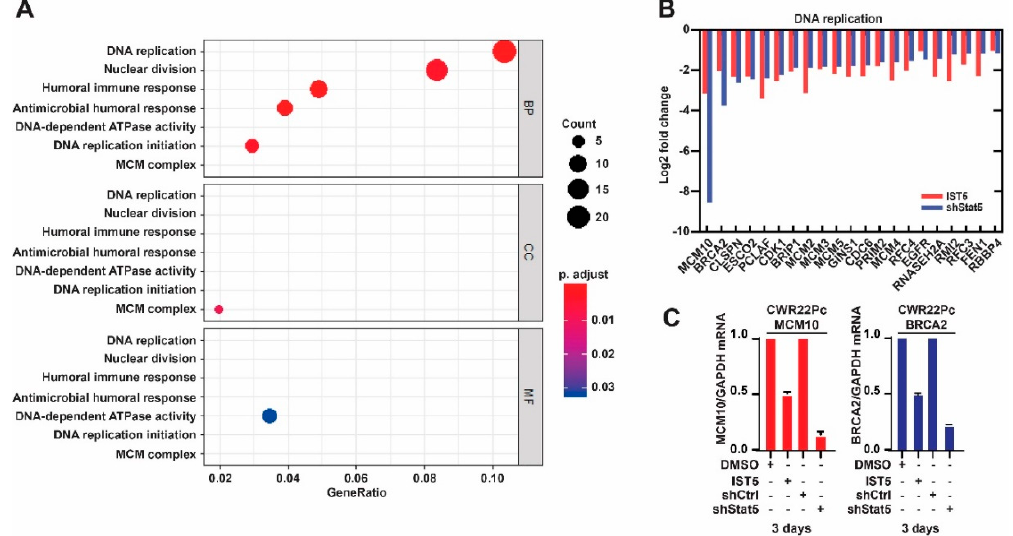
Figure 3. Pathway enrichment analysis of genes regulated similarly by IST vs. genetic knockdown of Stat5 in prostate cancer cells. ( A ), a dot plot of functionally enriched pathways in the genes regulated both by IST5 and genetic knockdown of Stat5 in PC with corresponding adjusted p values is shown. The size of each dot represents the number of transcripts in the corresponding pathway and the color indicates the significance. ( B ), a key cluster of 21 genes associated with the enriched pathways related to DNA replication which were regulated by both IST5 and genetic knockdown of Stat5 in PC cells. Log2 fold change is shown. ( C ), mRNA levels of MCM10 and BRCA2 were reduced, determined by quantitative real-time polymerase chain reaction (qRT-PCR), in CWR22Pc cells upon genetic knockdown of Stat5 by lentiviral expression of shStat5 vs. shCtrl or by treatment with IST5 (6 µM) vs. vehicle for 3 days.